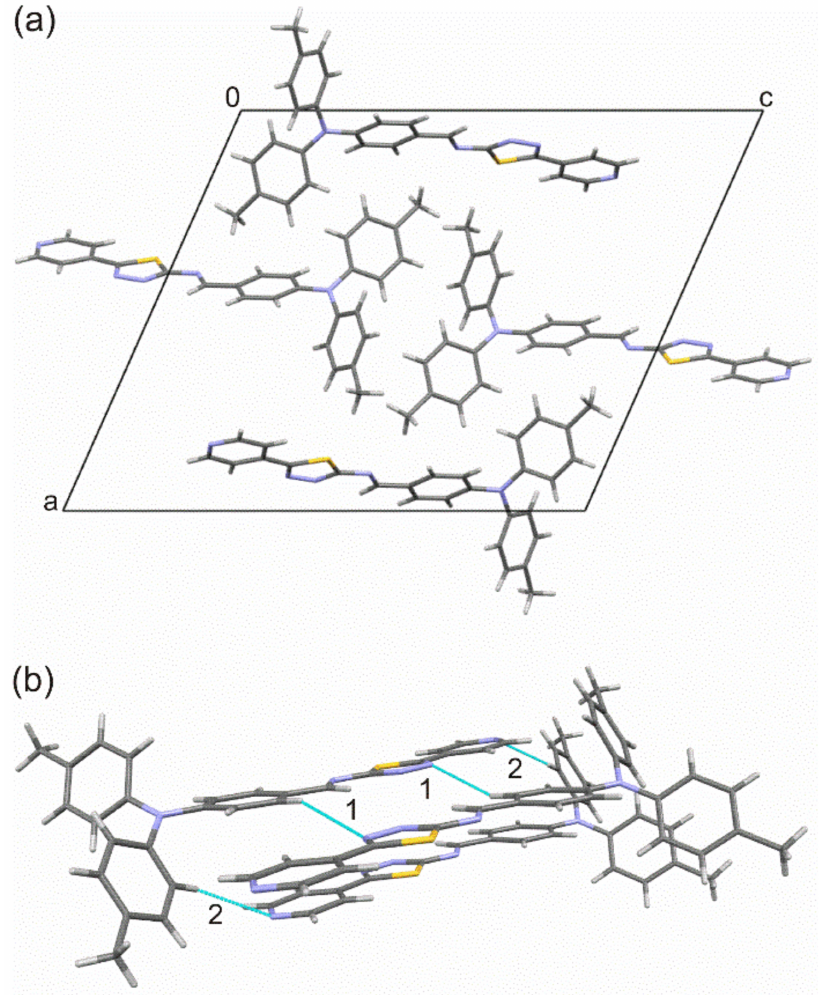
Figure 2. ( a ) Unit cell of PPL9, ( b ) intermolecular interactions for PPL9, where (1) is C17 − H17 · · · N4 and (2) is C6 − H6 · · · N5.